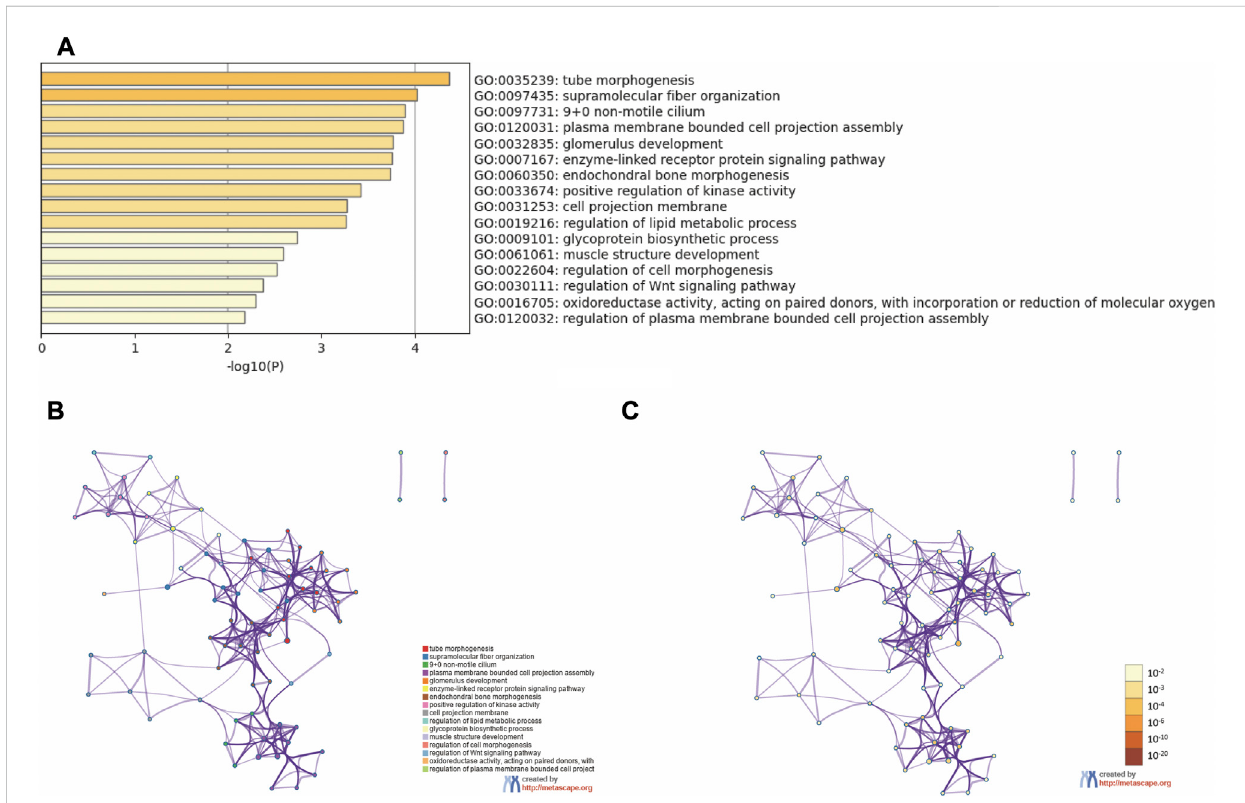
FIGURE 4 Functionalenrichmentanalysis. (A) Bargraphofenrichedterms. (B) NetworkofenrichedtermscoloredbyclusterID. (C) Networkofenrichedterms colored by p